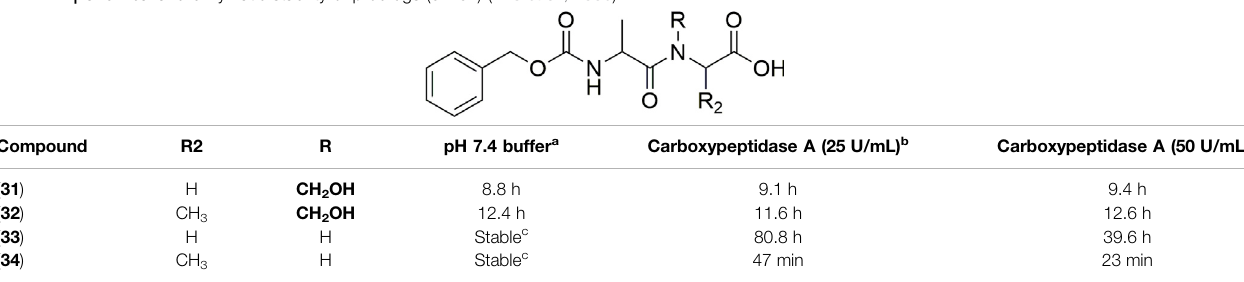
TABLE 2 | Chemical and enzymatic stability of prodrugs ( 31 – 34 ) (Friis et al., 1996).